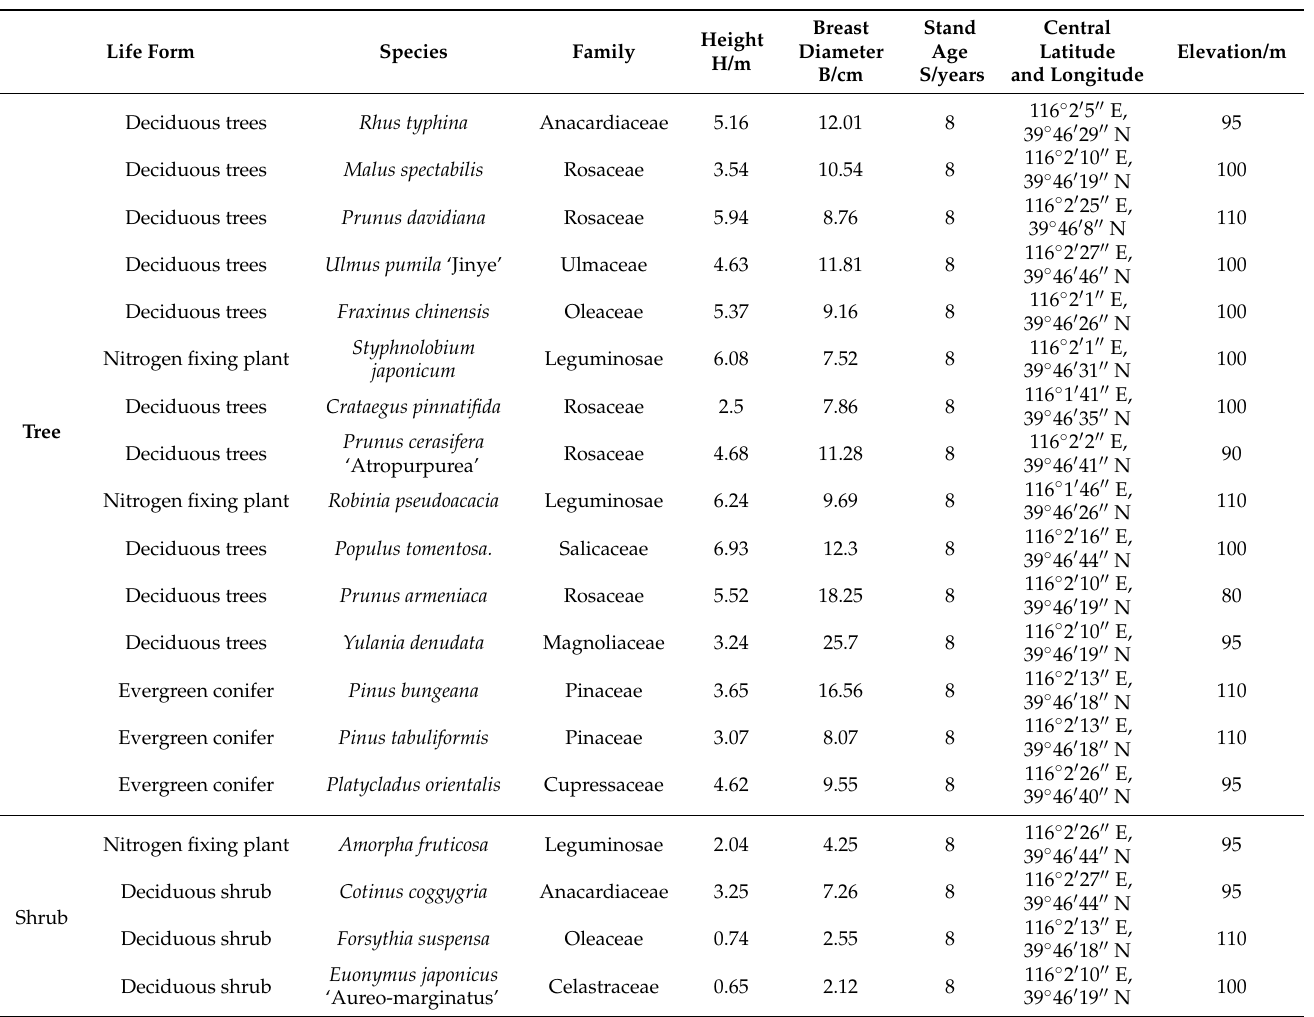
Table 1. List of the 19 species in the plantation in Qinglonghu,